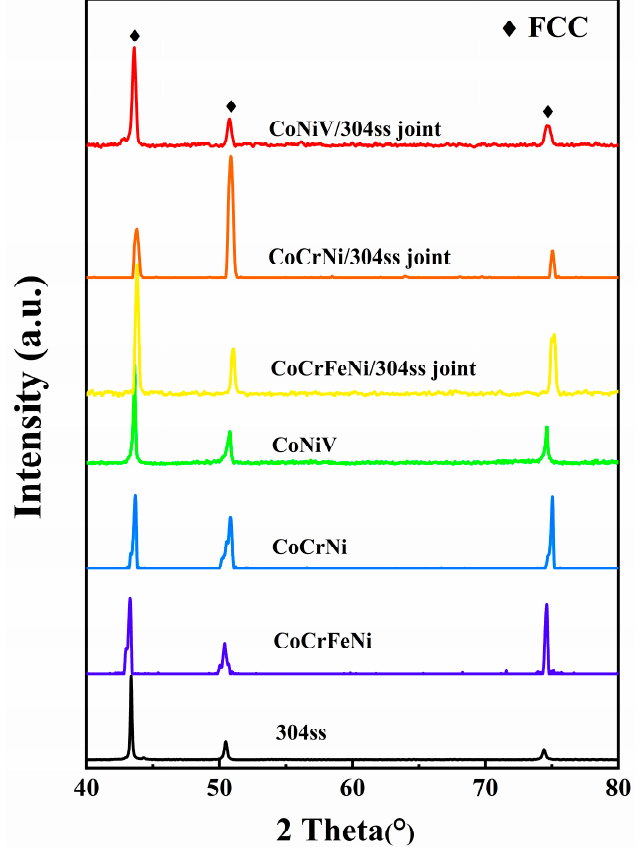
Figure 2. XRD pa tt erns of base materials before welding and the corresponding fusion zone of the Figure 2. XRD patterns of base materials before welding and the corresponding fusion zone of the welded joint. welded